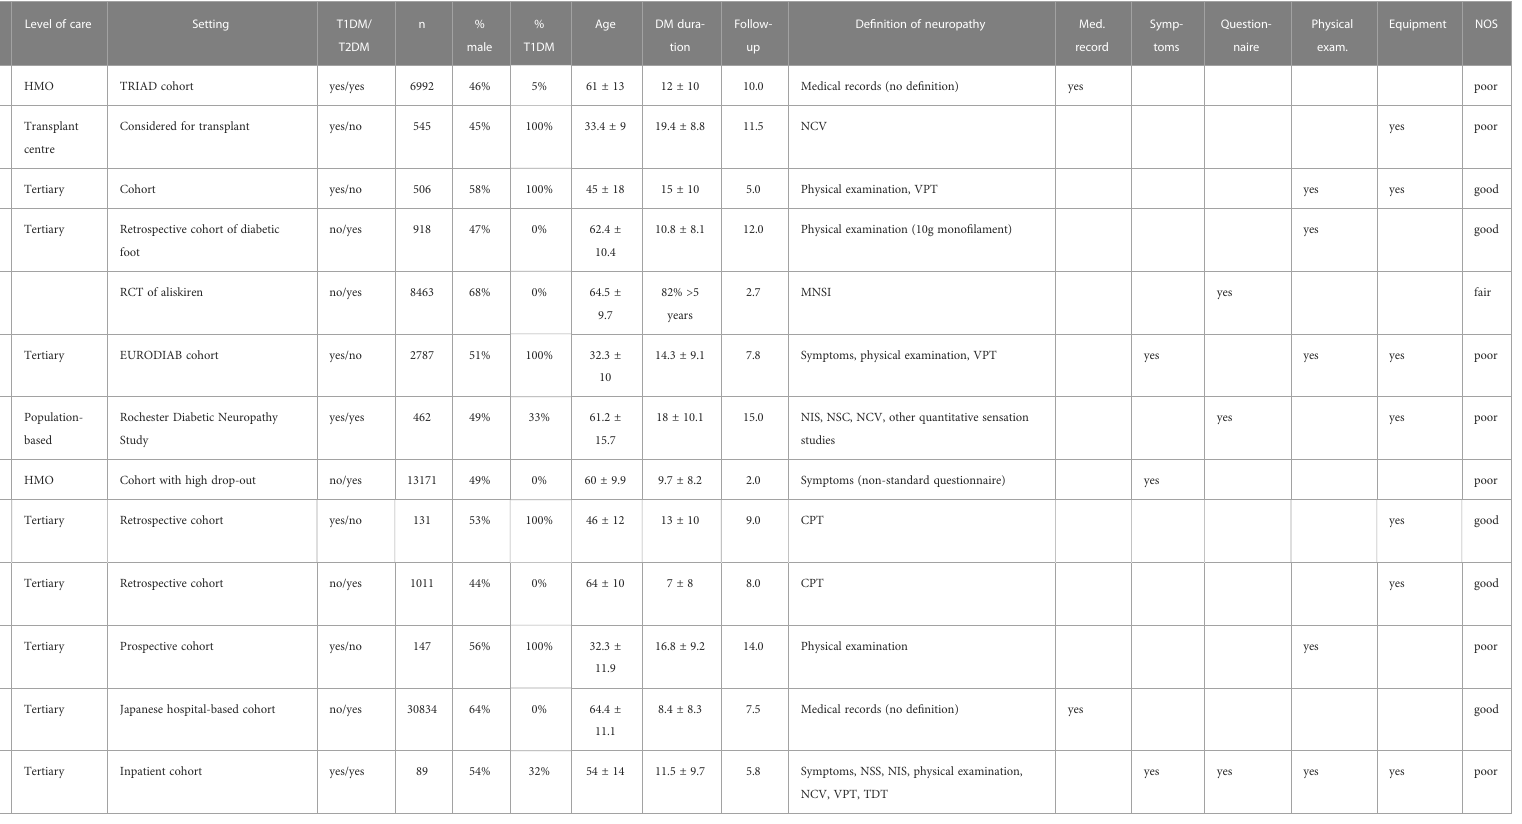
yes yes yes yes poor NCV, VPT, TDT